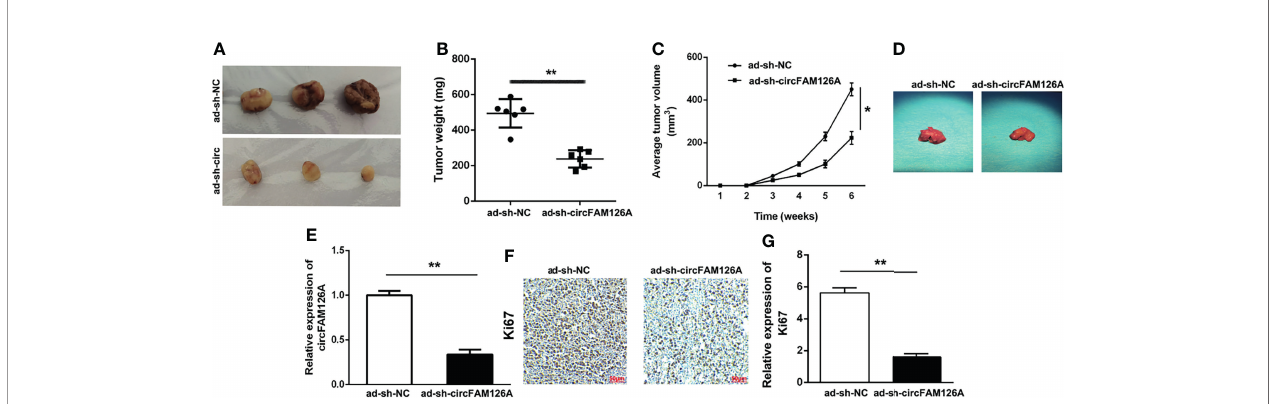
FIGURE 4 | circFAM126A shRNA inhibits the growth of OSCC tumor in vivo . (A) Xenograft analysis of tumor growth in vivo . circFAM126A knockdown suppressed OSCC tumor growth. (B, C) Tumor weight and volume after transfection with circFAM126 knockdown. (D) The suppression of liver metastasis induced circFAM126 knockdown. (E) Expression of circFAM126 in vivo detected using qRT-PCR. (F, G) Expression of Ki67 in OSCC determined by immunohistochemistry. * P <0.05, ** P <0.01.